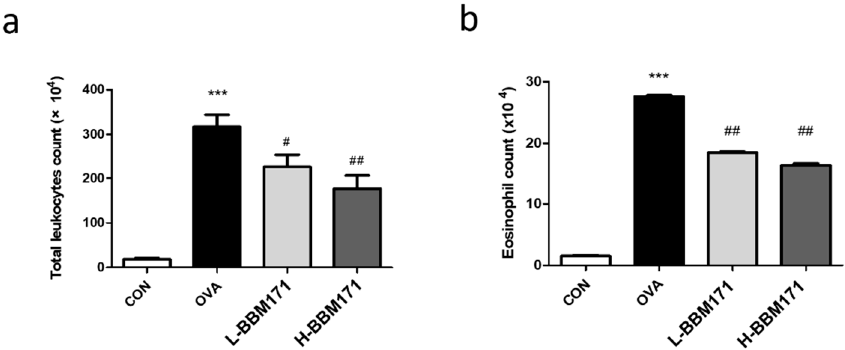
Figure 4. Effects of L. paragasseri BBM171 intervention on the distribution of immune cells in BALF. ( a ) total count of leukocytes. ( b ) cell population of eosinophils. Data are expressed as mean ± SEM and analyzed by one-way ANOVA with Tukey’s post hoc test. Significant differences at *** p < 0.001 compared with the CON group. # p < 0.05 and ## p < 0.01 compared with the OVA